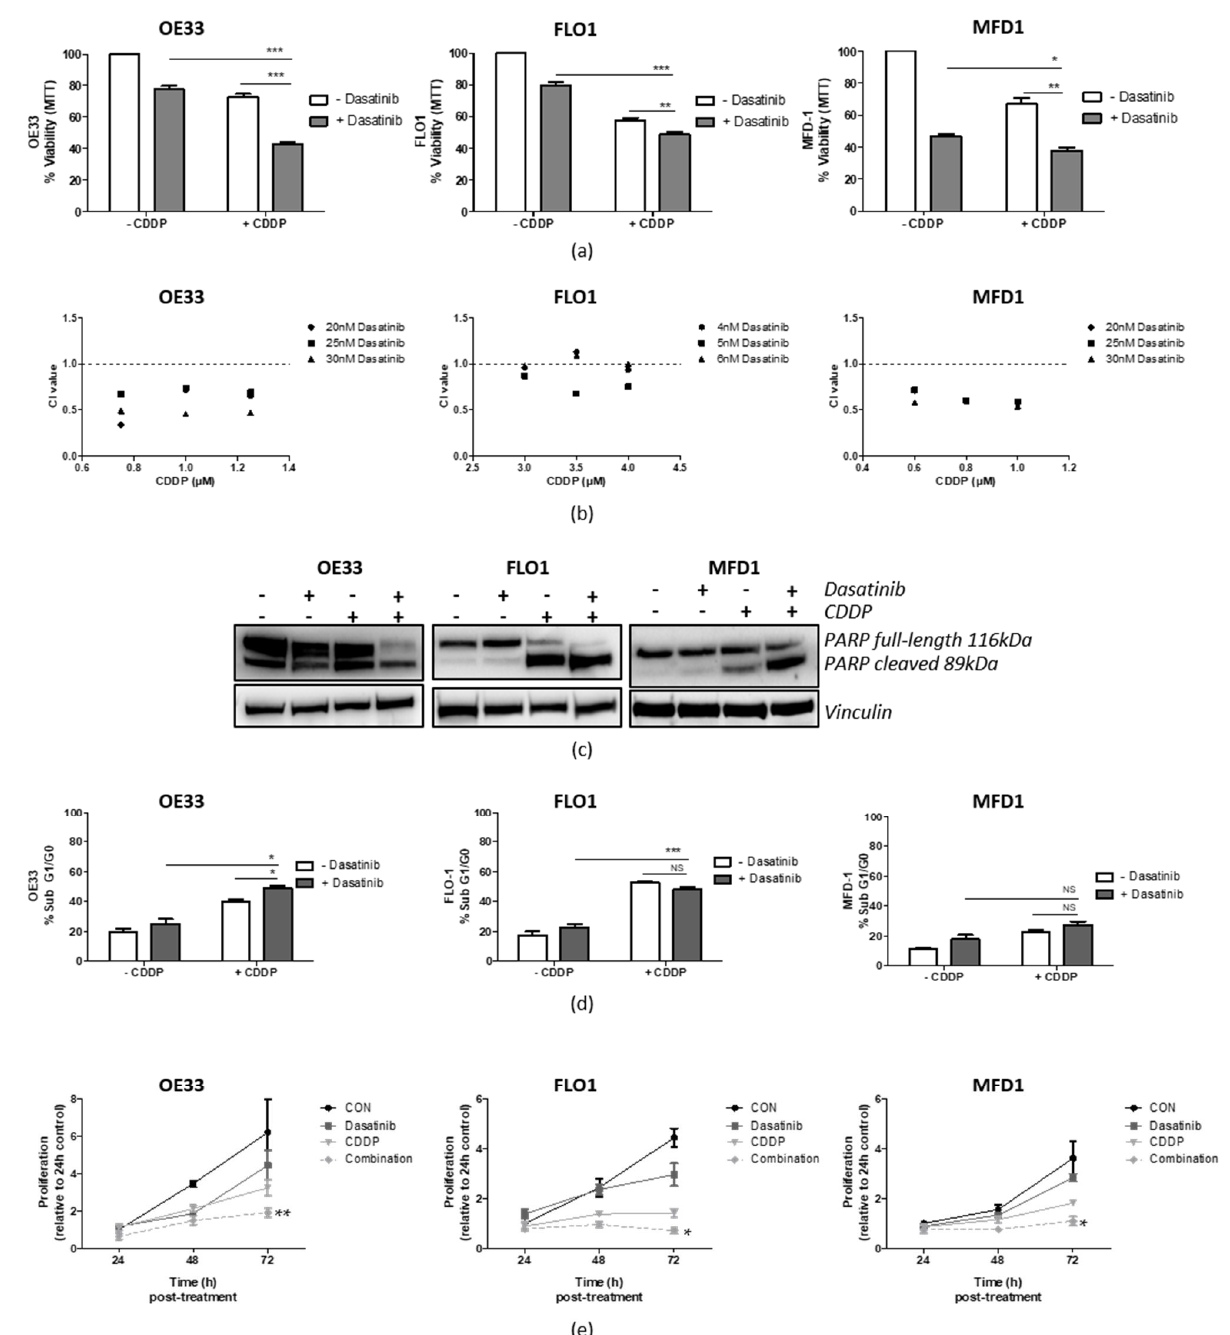
Figure 4. Dasatinib synergises with CDDP in OAC cell lines: ( a ) OAC cells were treated with ~IC 30(72h) doses of dasatinib/CDDP for 72 h and viability was assessed by MTT. The results represent the mean ± SEM of triplicate experiments. ( b ) Drug interactions were then assessed following 72 h dasatinib/CDDP combinations ( ≤ ~IC 30(72 h) ) by combination index (CI), where a CI < 1 indicates synergy, CI = 1 indicates additive, and CI > 1 indicates an antagonistic interaction. ( c ) Western blot analysis of PARP in OE33 FLO-1 and MFD-1 cells following 72 h ~IC 30 (72 h) dasatinib/CDDP combinations with vinculin as a loading control. ( d ) Propidium iodide flow cytometry of Sub-G1 phase following 72 h ~IC 30(72 h) CDDP/dasatinib combination. ( e ) Proliferation rates at 24, 48, and 72 h post combination treatment. The results represent the mean ± SEM of triplicate experiments. Significance was assessed using Student’s t -test (* p < 0.05, ** p < 0.01, *** p < 0.001). CON, control; NS, not